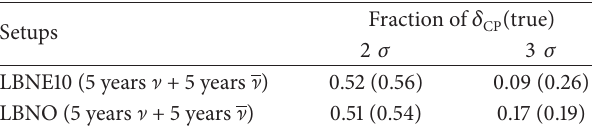
(true) for which a discovery is possible for Table 4: Fractions of 𝛿 CP CP violation. The numbers without (with) parentheses correspond to NH (IH) as true hierarchy. The results are presented at 2𝜎 and 3𝜎 confidence